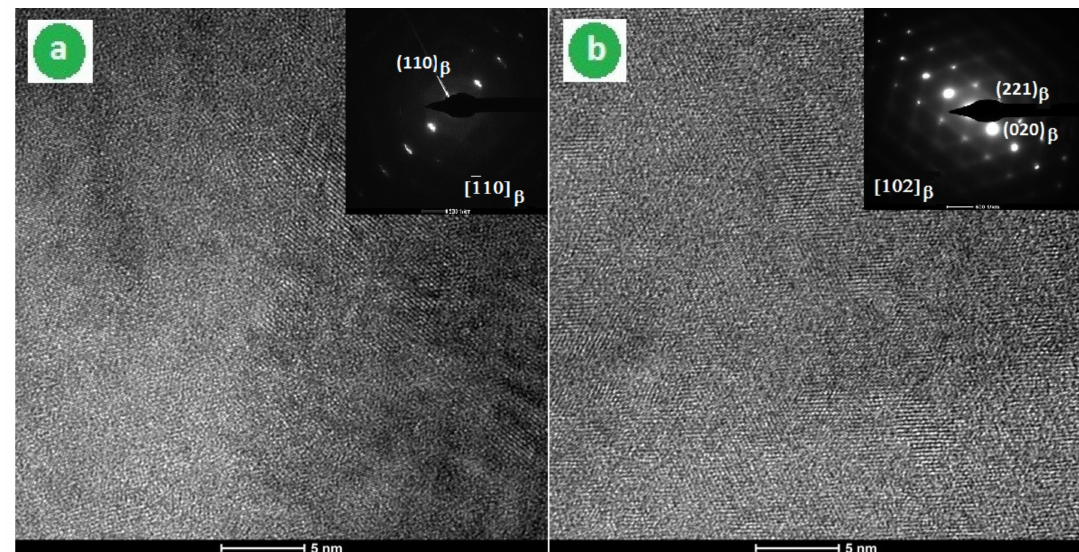
Figure 7. HRTEM images corresponding to both ST variants—V-1 and V-2—applied on the studied alloy: ( a ) V-1: bright field image and the SAED image observed along the [110] β zone axis; ( b ) V-2: bright field image and the SAED image observed along the [102] β zone axis.